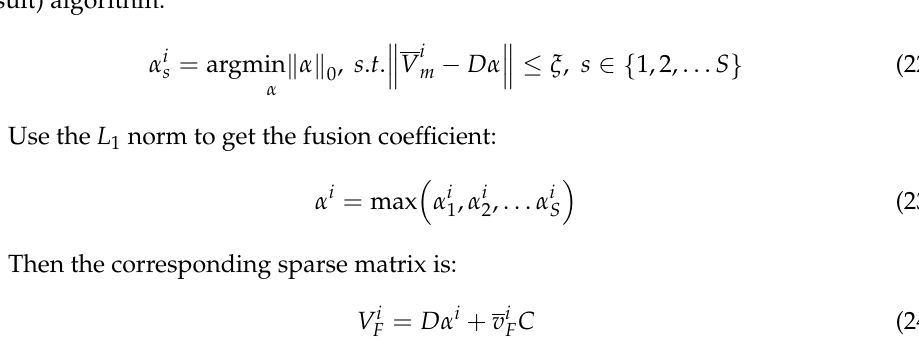
where C is an n × 1 dimensional identity matrix, and v i elements. The sparsity coefficient is calculated according to the OMP (Orthogonal Matching